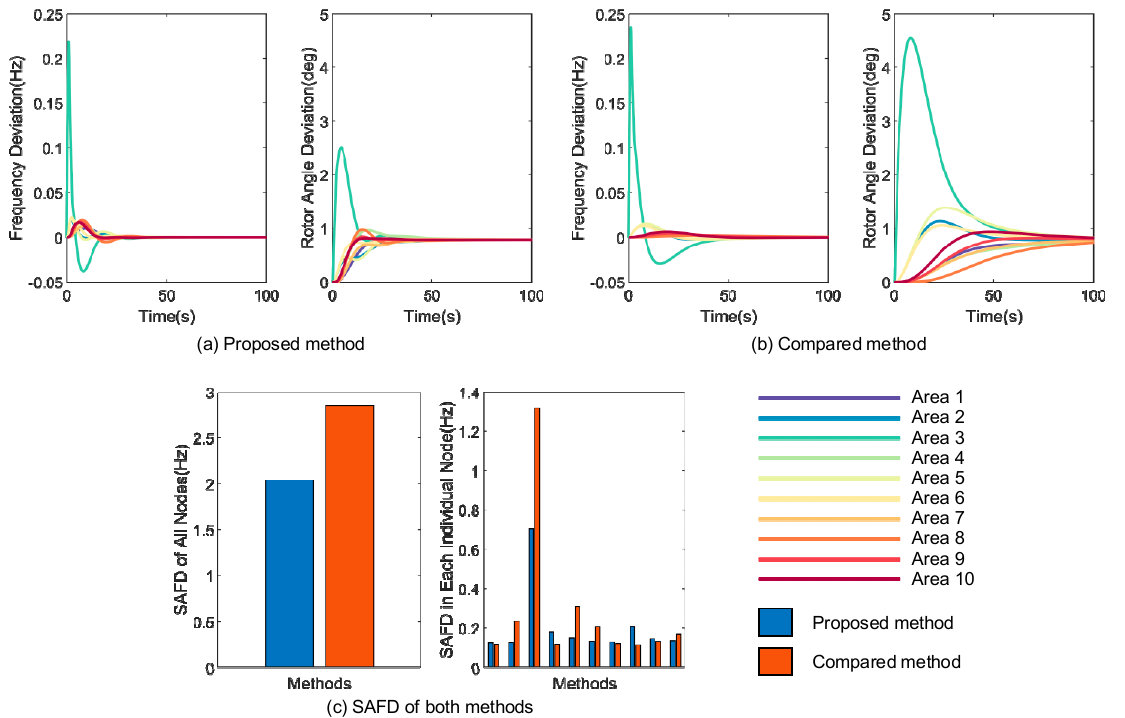
Figure 8. Frequency deviation, rotor angle deviation and sum of absolute frequency deviation (SAFD) of both methods in the frequency event B.